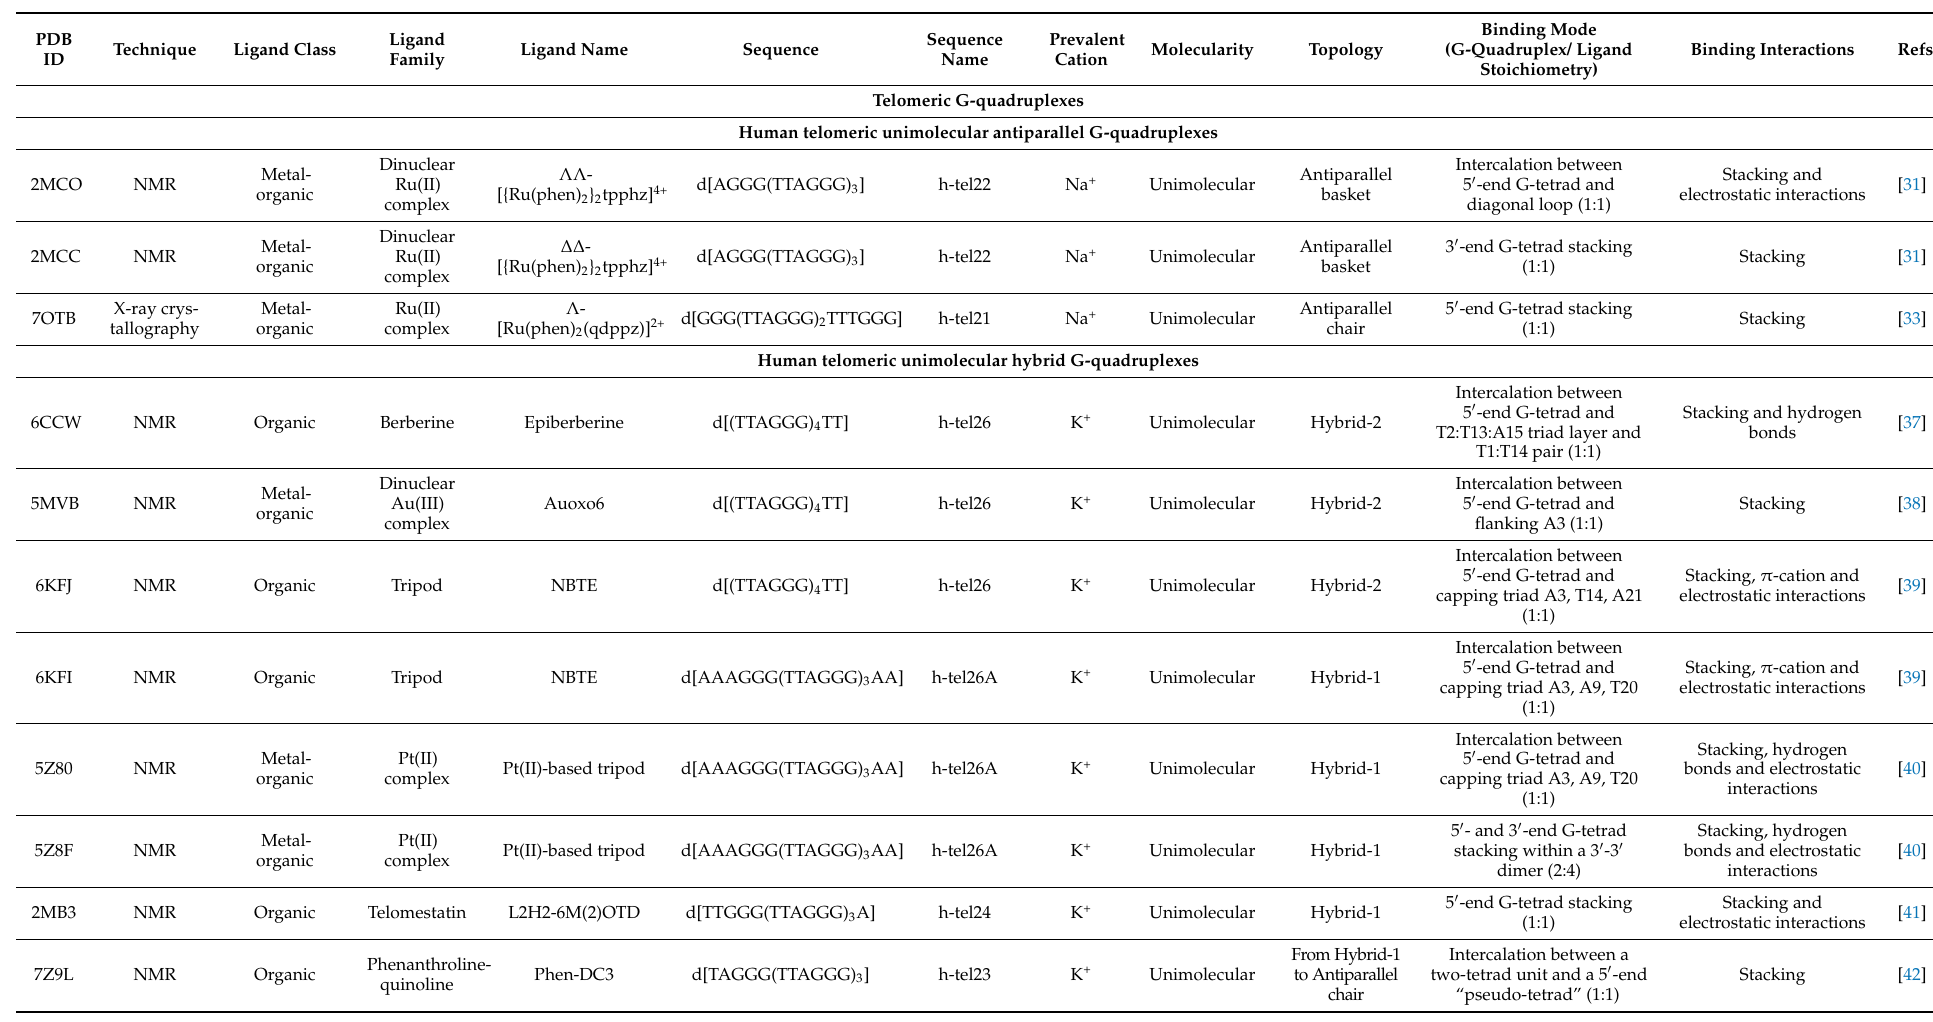
Table 1. Summary of the features of ligands and G-quadruplex targets within the NMR and crystal structures solved thus far for G-quadruplex/small-molecule ligand